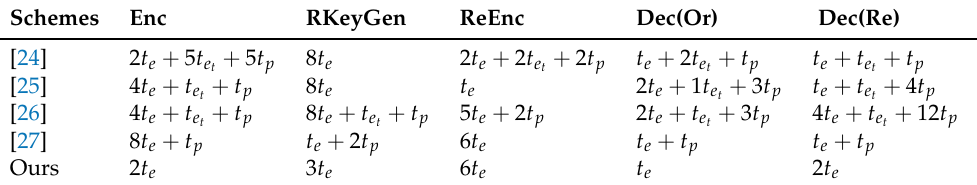
Table 1. Computing cost